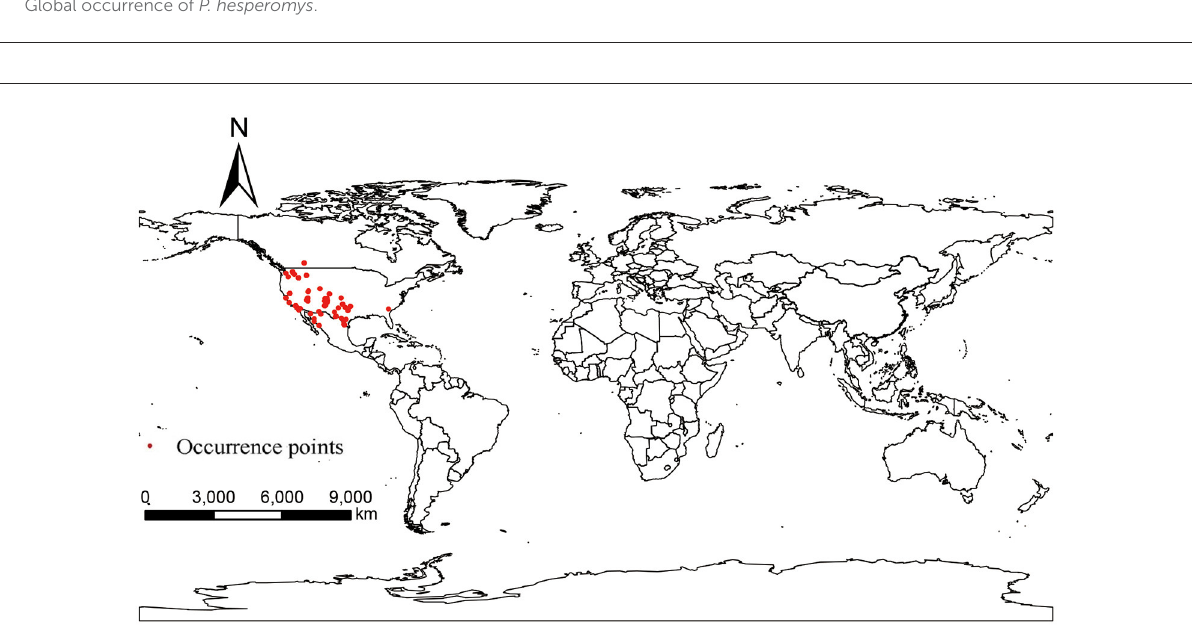
FIGURE2 Global occurrence of O. sexdentatus